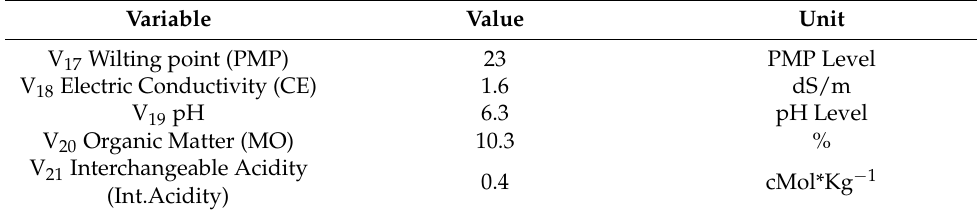
Table A8. Fuzzy model input parameters: reactive